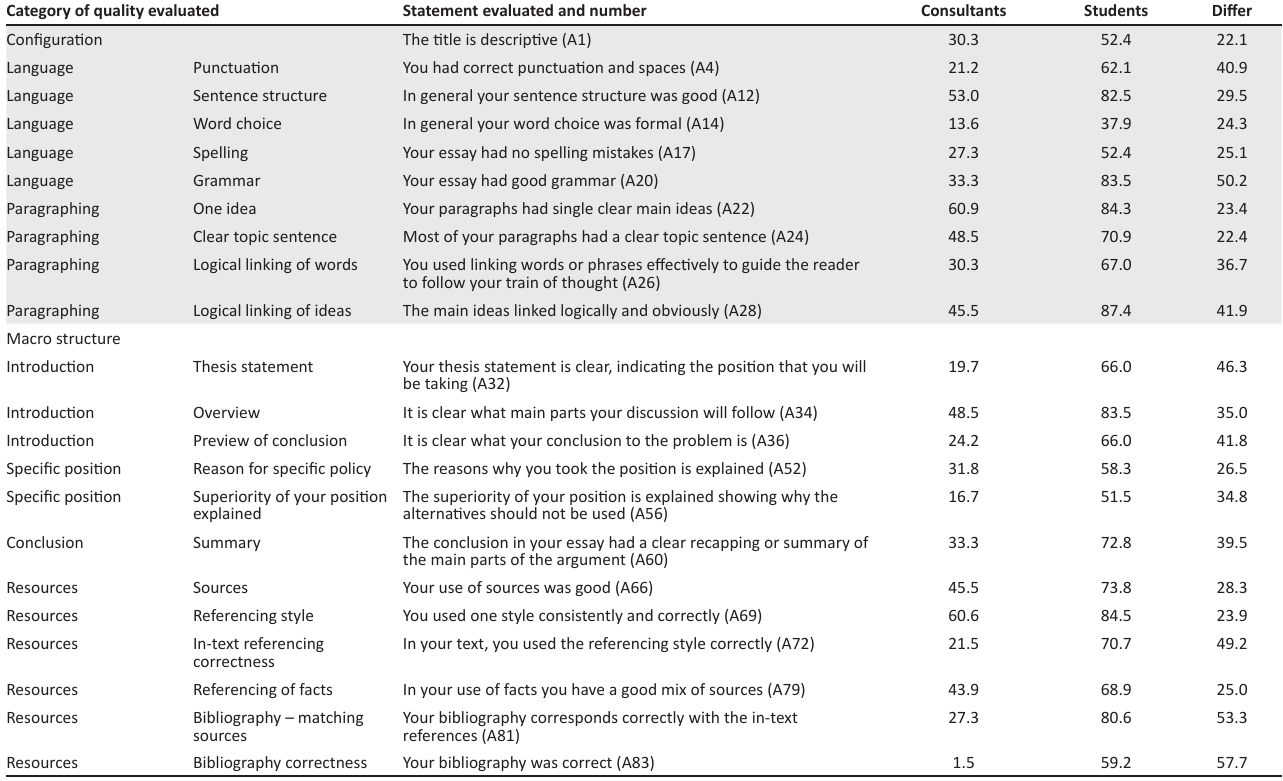
TABLE 1: Comparing the evaluation between writing consultants and students. Category of quality